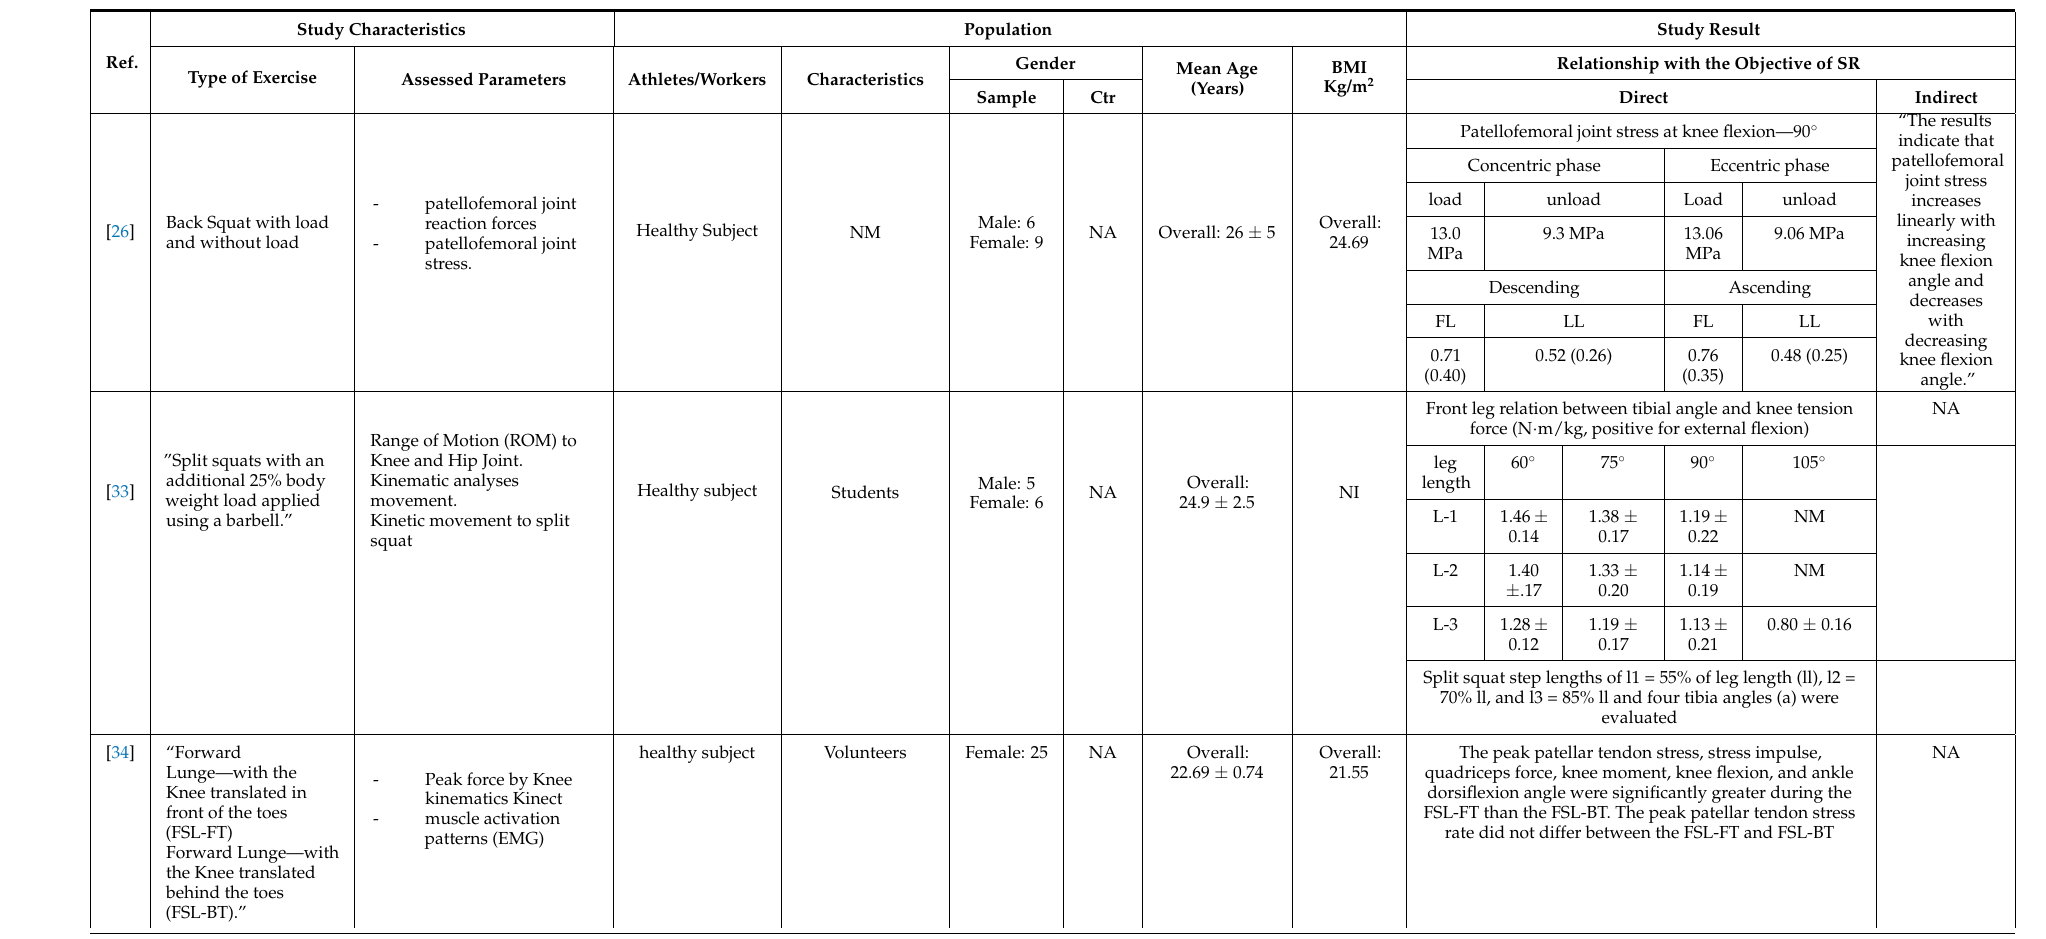
The peak patellar tendon stress, stress impulse, quadriceps force, knee moment, knee flexion, and ankle dorsiflexion angle were significantly greater during the FSL-FT than the FSL-BT. The peak patellar tendon stress rate did not differ between the FSL-FT and